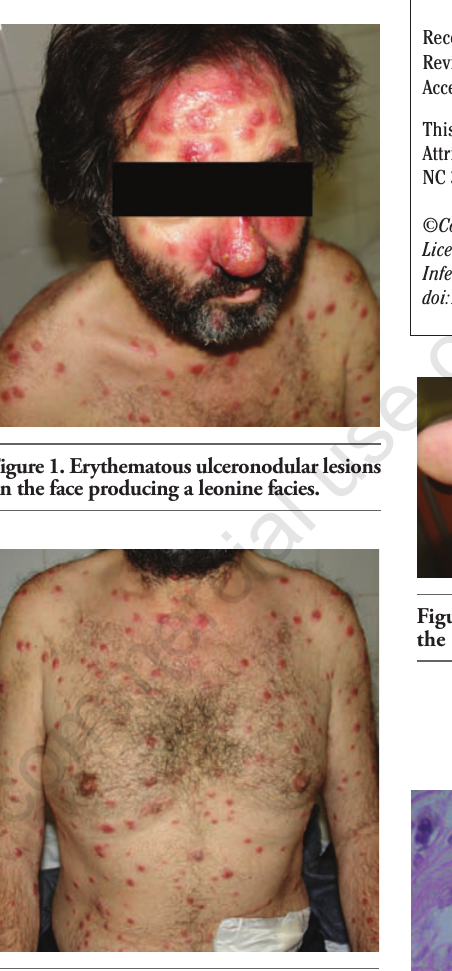
Figure 2. Multiple, erythematous ulceron- odular lesions affecting the trunk.